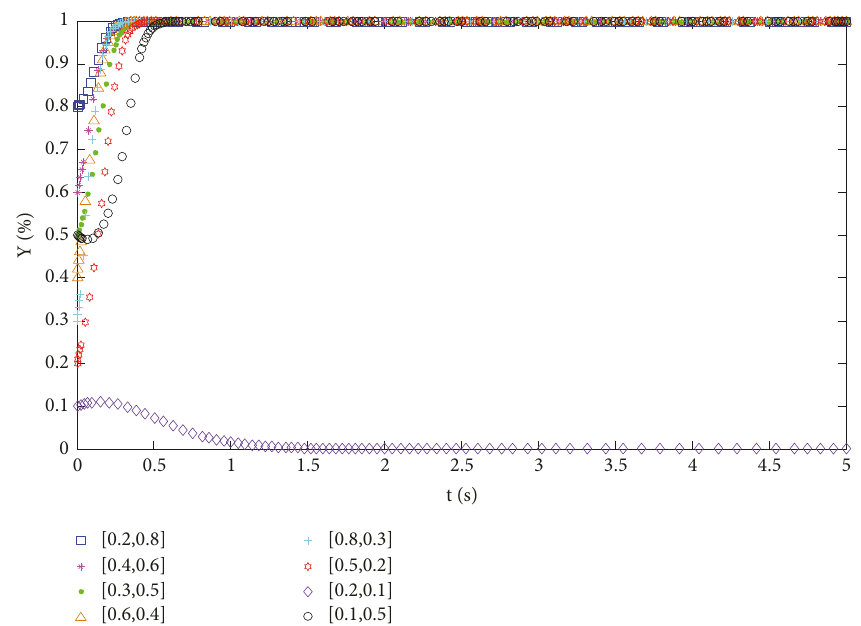
Figure 6: The Y-t type of phase diagram (ESS: D(1,1) & A(0,0)).